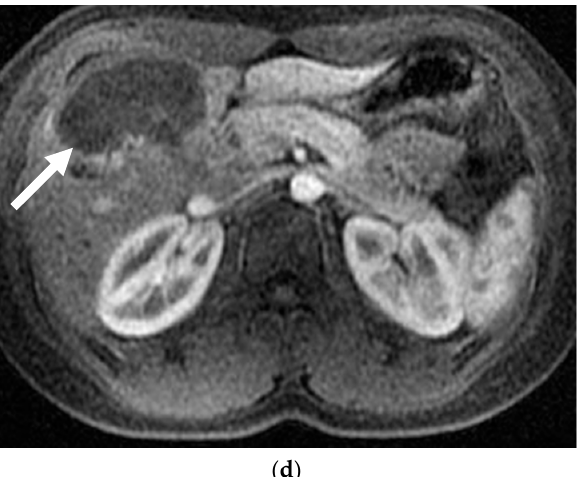
Figure 2. A 24-year-old female with focal nodular hyperplasia (FNH) and right upper quadrant pain. ( a ) Magnetic resonance imaging (MRI) with contrast demonstrates a hypervascular lesion in segments 4 and 5 (solid white arrow). Twenty-minute delayed images showed continued enhancement (not shown). ( b ) Angiogram reveals segment 4 and segment 5 arteries that feed a hypervascular mass. Each artery was infused with 200 and 300 µm PVA particles until stasis. ( c ) Post-embolization angiogram shows no flow to the FNH. ( d ) MRI with contrast one month after embolization reveals no residual enhancement and a decrease in the size of the FNH (solid white arrow). The patient’s pain resolved following the embolization.